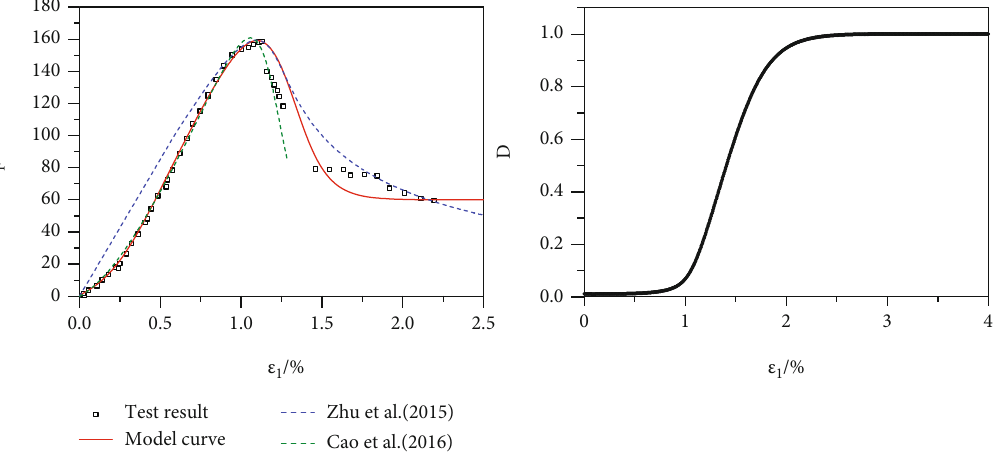
Figure 14: Axial stress-strain curve and damage curve under con fi ning pressure of 10MPa.